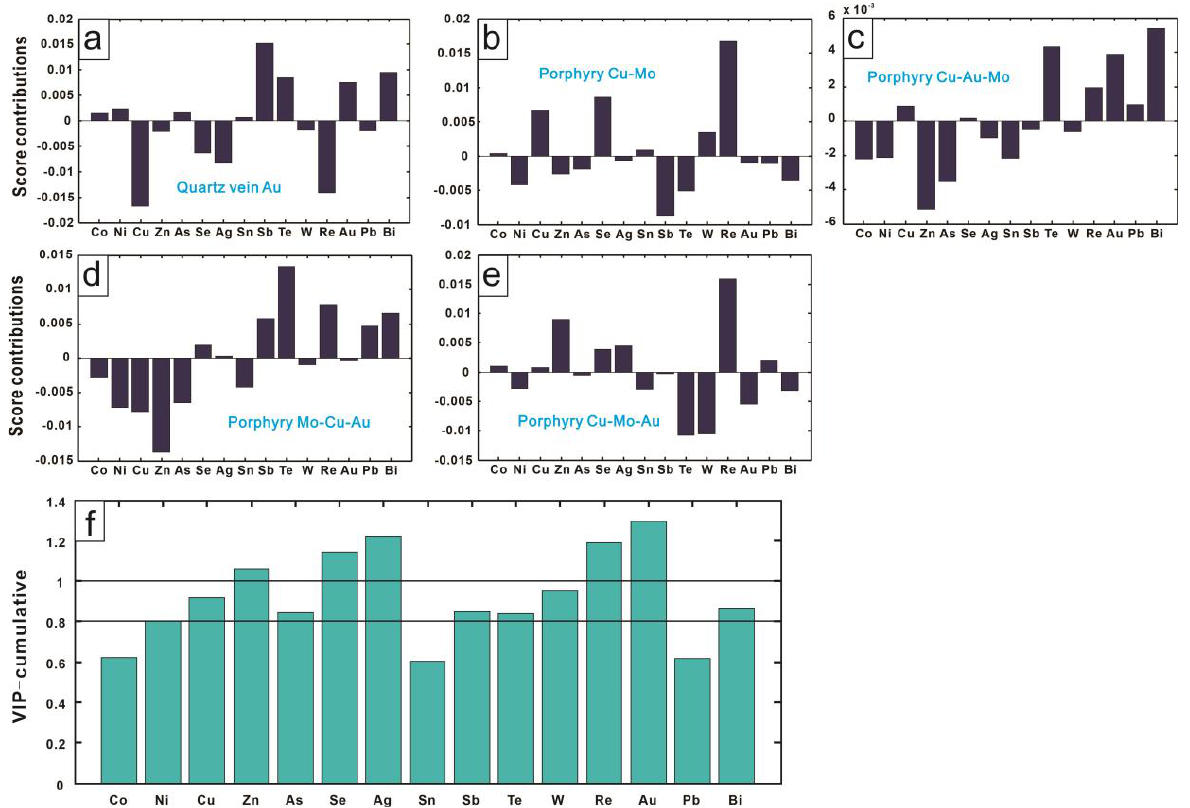
Figure 4. Score contribution ( a – e ) and VIP-cumulative plot ( f ) corresponding to PLS-DA results in Figure 3.